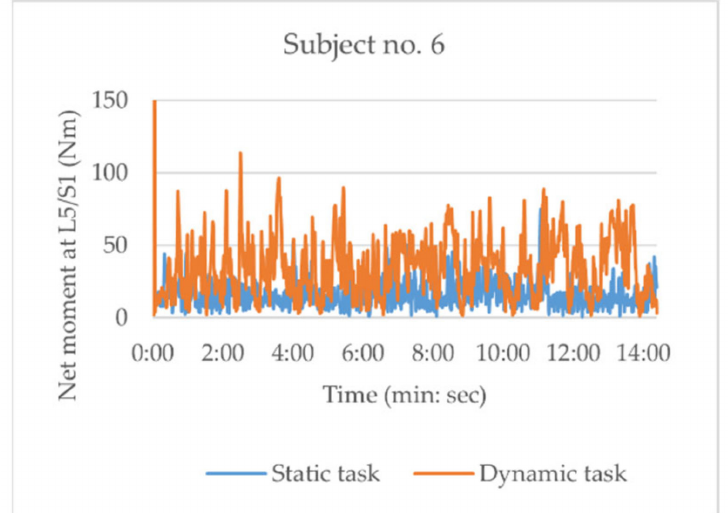
Figure 3. Typical example of net moment curves during static (blue) and dynamic (orange) tasks (Subject 6).